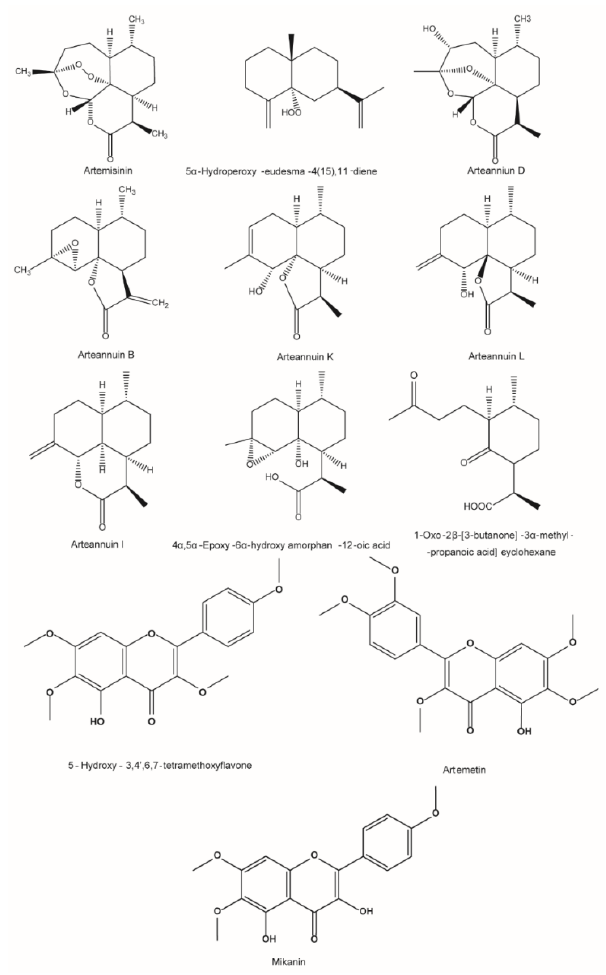
Figure 7. The structures of different compounds and speculated antimalarial active compounds.